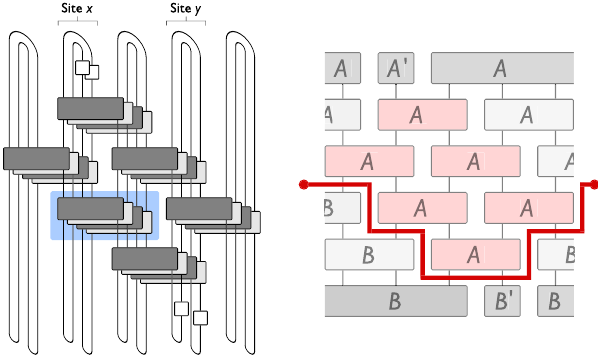
FIG. 10. Diagrammatic representation of OTOC. Left: Folded diagram for tr ½ O ð x; t Þ O ð y Þ O ð x; t Þ O ð y Þ(cid:2) with j x − y j ¼ 2 and t ¼ 2 . The blue box highlights four unitary operators, which can be represented in the block representation in a similar way as the ones in Fig. 9(c). Right: An apparent minimal-length horizontal DW diagram that vanishes due to tr O ð y Þ ≡ 0 . The red blocks are unitary pairs that cannot be annihilated. The dark gray blocks represent the boundary conditions. A 0 represents an effective contraction A [Fig. 9(c)] with operators along the loops, and similar for B 0